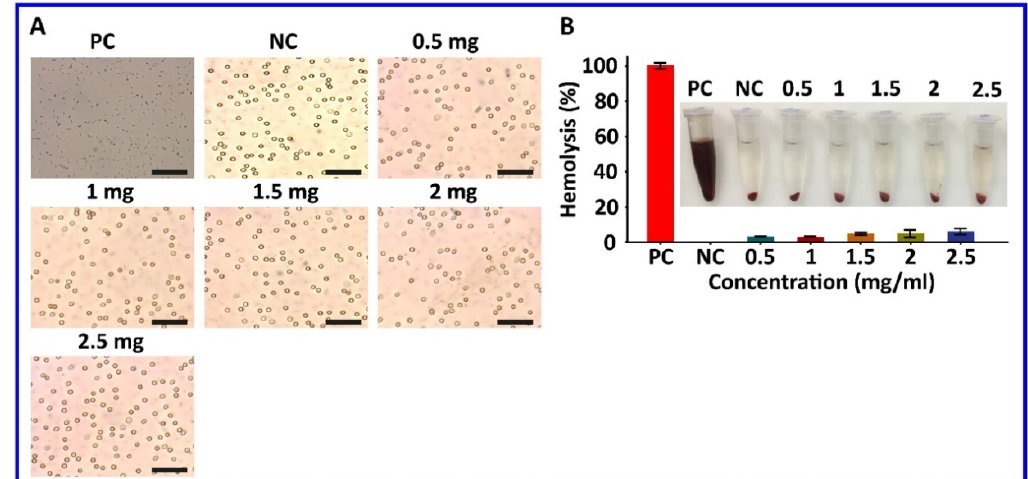
Figure 12. Hemotoxicity assay. ( A ) Microscopic examination of RBC membrane damage at 2 h post-incubation with A549/T CM-HNPs at various concentrations (0.5–2.5 mg/mL). ( B ) Quantitative estimation of RBC membrane damage and hemoglobulin release at 2 h post-incubation. Triton-X (20%) and saline were used as positive and negative controls (PC and NC), respectively.